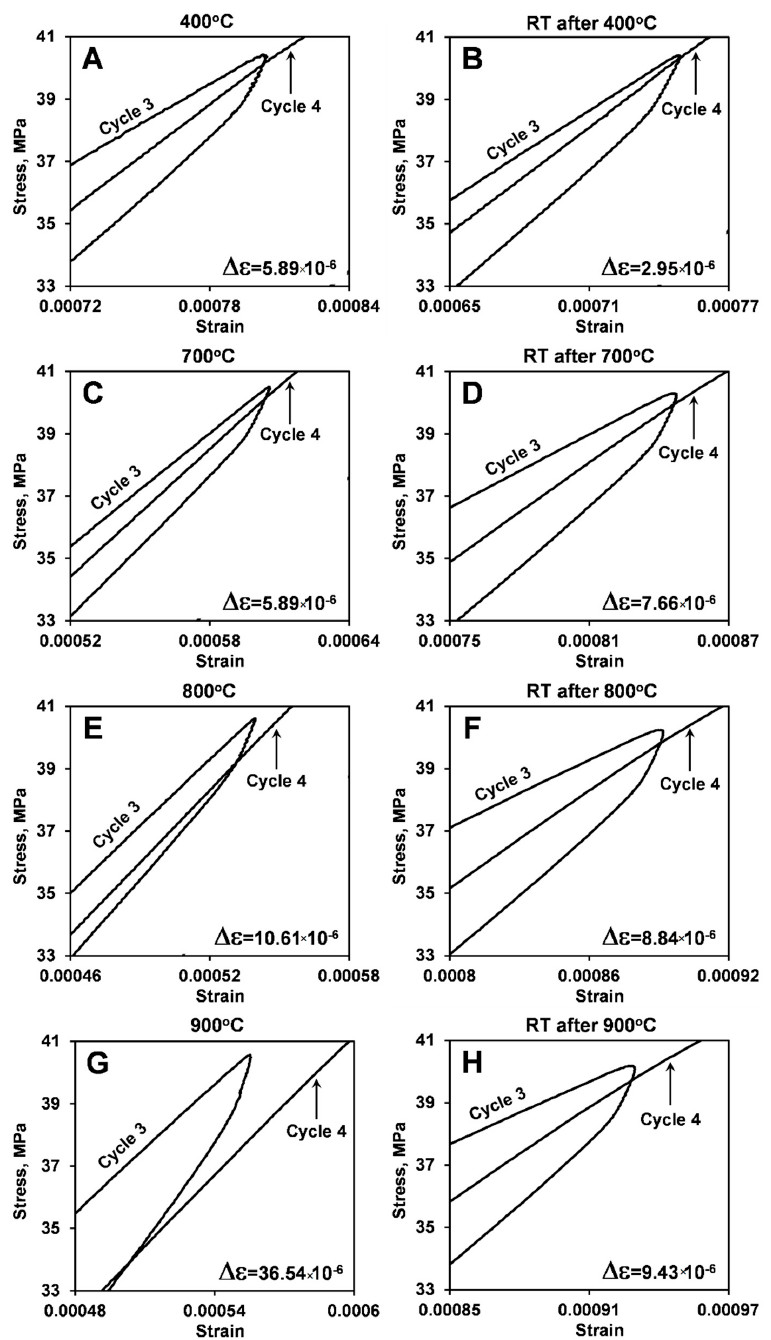
Figure 6. Portions of cycle 3 loading/unloading and cycle 4 loading stress-strain deformation plots of LaCoO 3 sample #1 showing the presence of creep strain shift Δ ε at testing performed at different temperatures: ( A ) 400 °C; ( B ) RT after 400 °C; ( C ) 700 °C; ( D ) RT after 700 °C; ( E ) 800 °C; ( F ) RT after 800 °C; ( G ) 900 °C; ( H ) RT after 900 °C. The corresponding values of Δ ε are shown in Table 3.